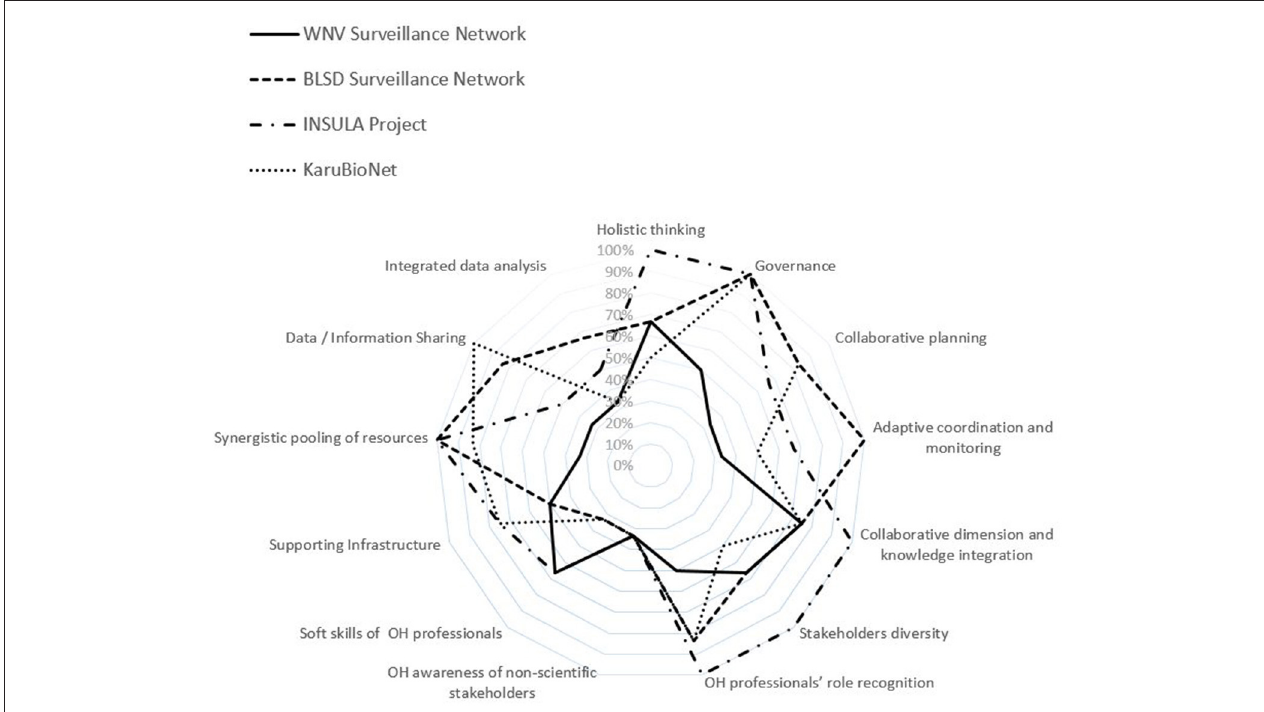
FIGURE 1 | Radar diagrams displaying the scores (in %) for each ECOHI criterion for all the initiatives ( Supplementary Figures 1A–D ).